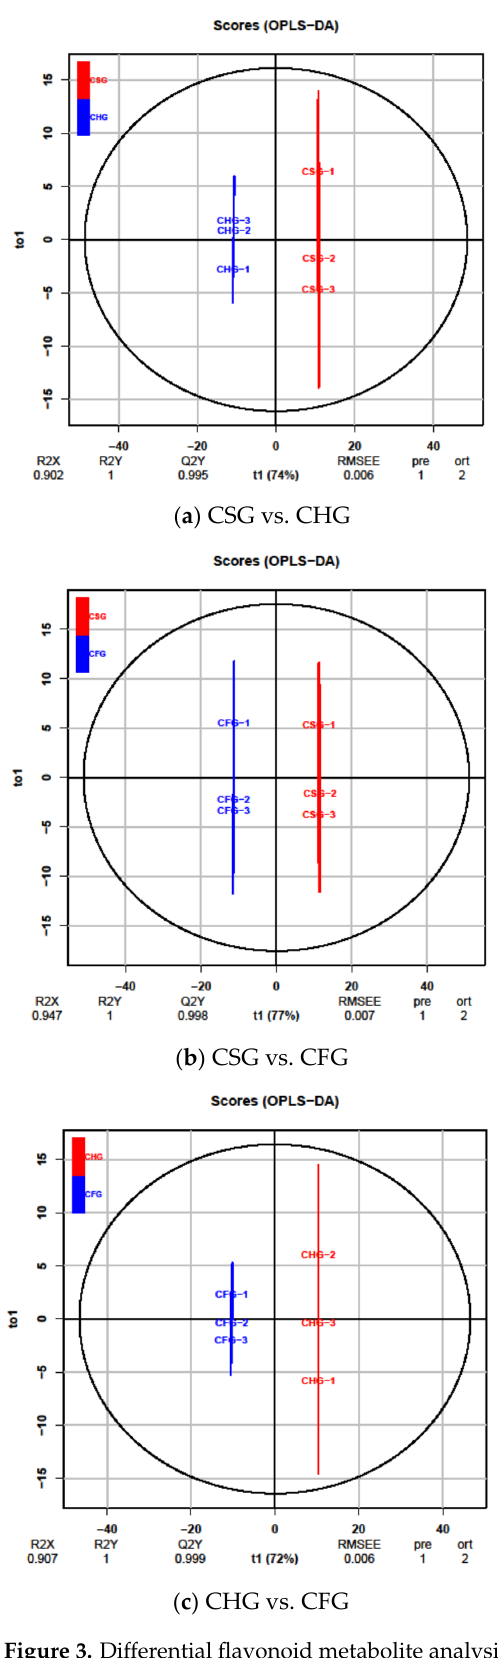
Figure 3. Differential flavonoid metabolite analysis on the basis of orthogonal signal correction and partial least squares discriminant analysis (OPLS-DA); ( a – c ) OPLS-DA model plots for comparison of CSG vs. CHG, CSG vs. CFG and CHG vs. CFG.